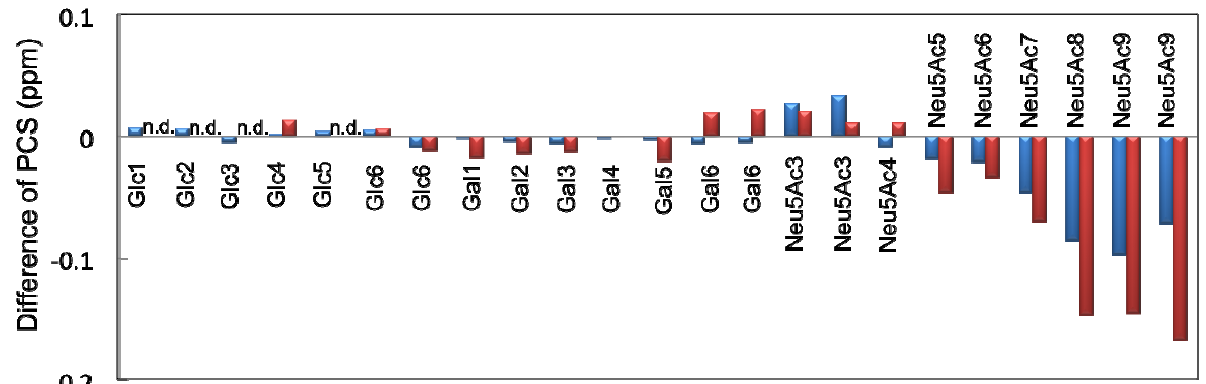
Figure 4. The differences of proton PCS values shown as subtraction of Δδ 1 tetrasaccharide from Δδ 1 of the GM3 trisaccharide with Tm 3+ (blue) and Tb 3+ (red). n.d., not H detected due to extensive line